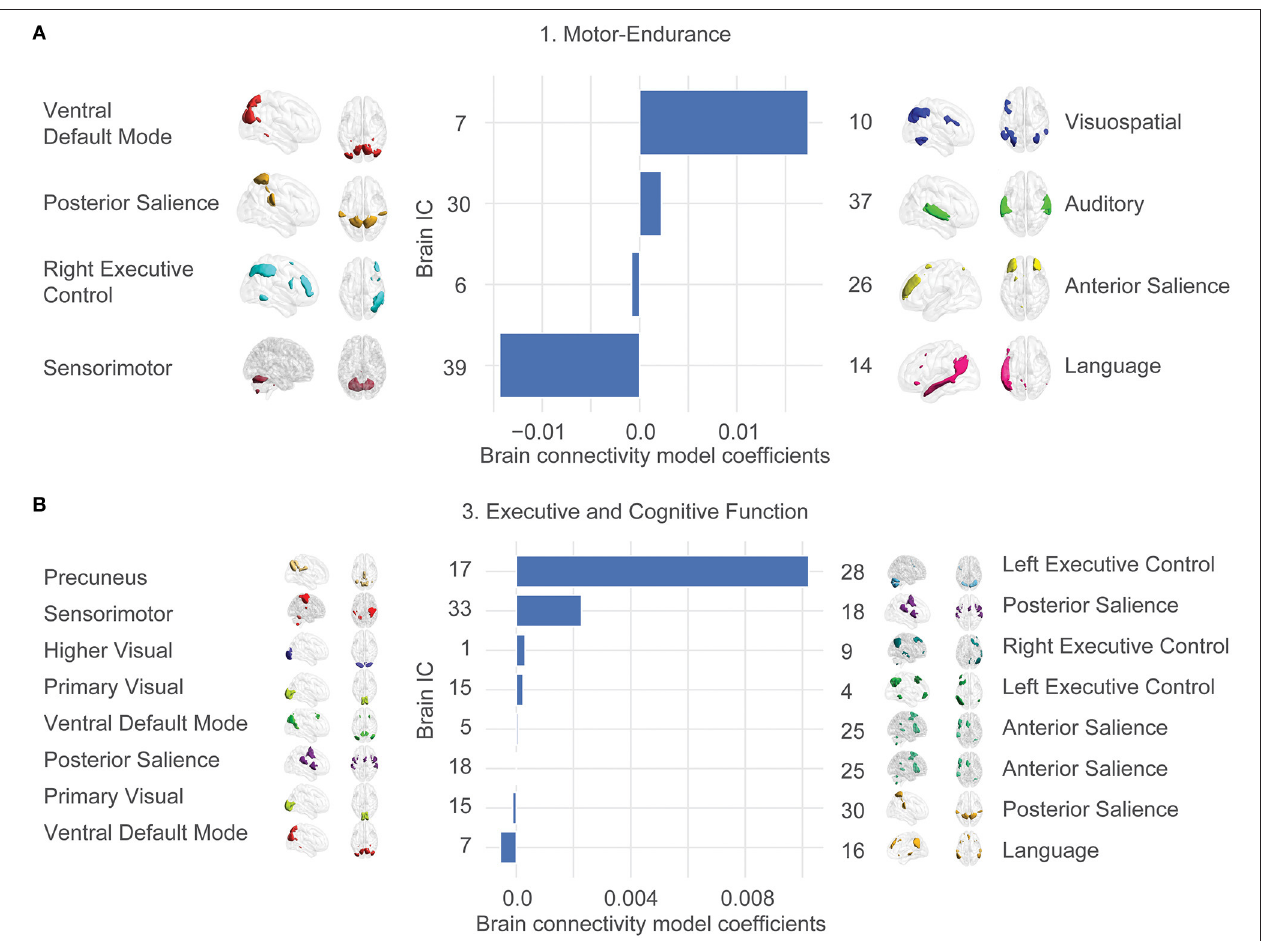
FIGURE 3 | Large-scale network connectivity determines ability trait 1 (Motor-endurance) and 3 (Executive and cognitive function). The large-scale network links were determined by averaging more regularized models and displaying the average coefficient for features that are prevalent in each model. Prevalence is determined by presence in 80% of the models. Only the two significant ability traits are displayed. Ability trait 2 and 4 show insignificant predictions out of sample. Template matching using canonical network templates (Shirer et al., 2012; Altmann et al., 2015) was performed. For visualization, ICA maps derived from the HCP consortium (dimensionality = 50) were thresholded at the top 1% z -score for non-null voxels and brains were displayed using the BrainNet viewer ( Xia et al., 2013). Note that the independent variables are all z-scored, so parameter values can be compared. The bars represent average model coefficients, not connectivity values. (A) Ability trait 1 (Motor-endurance) connectivity model coefficients. More connectivity between IC 7 and 10 indicates higher values of trait 1, for example. (B) Ability trait 3 (Executive and cognitive function) brain connectivity model coefficients.